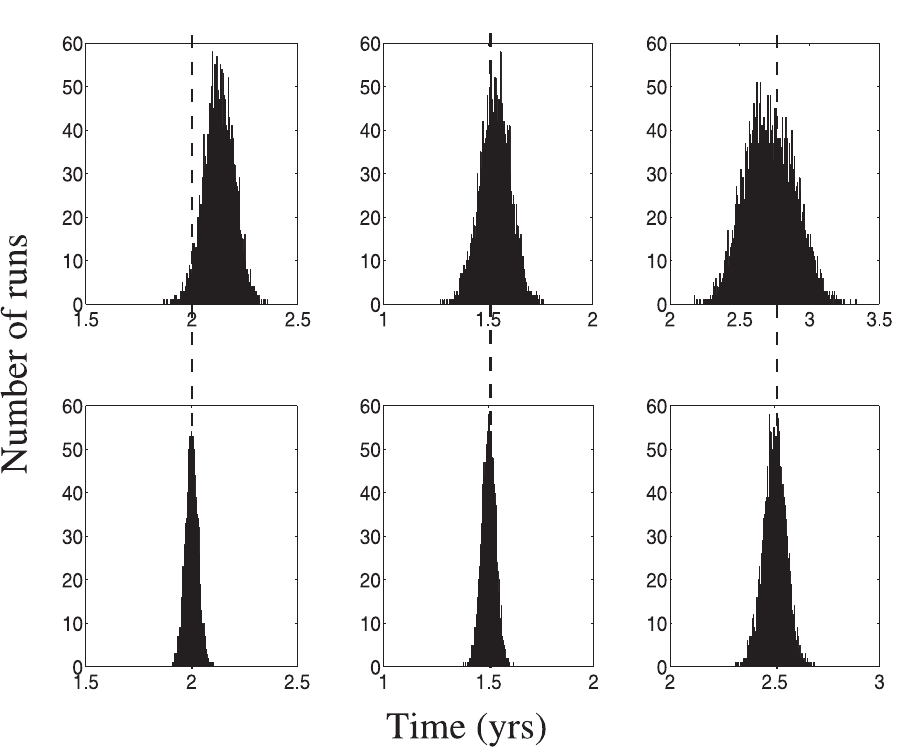
Figure 5. Counting method: the mean stage durations for data generation method 2 (the coarse case). Sets of 1,000 (top row) or 10,000 (bottom row) patients were considered. Each column presents the calculated mean for 7,500 simulations for stages 1–3 of a 4-stage disease. The true mean values are shown by dashed vertical lines.